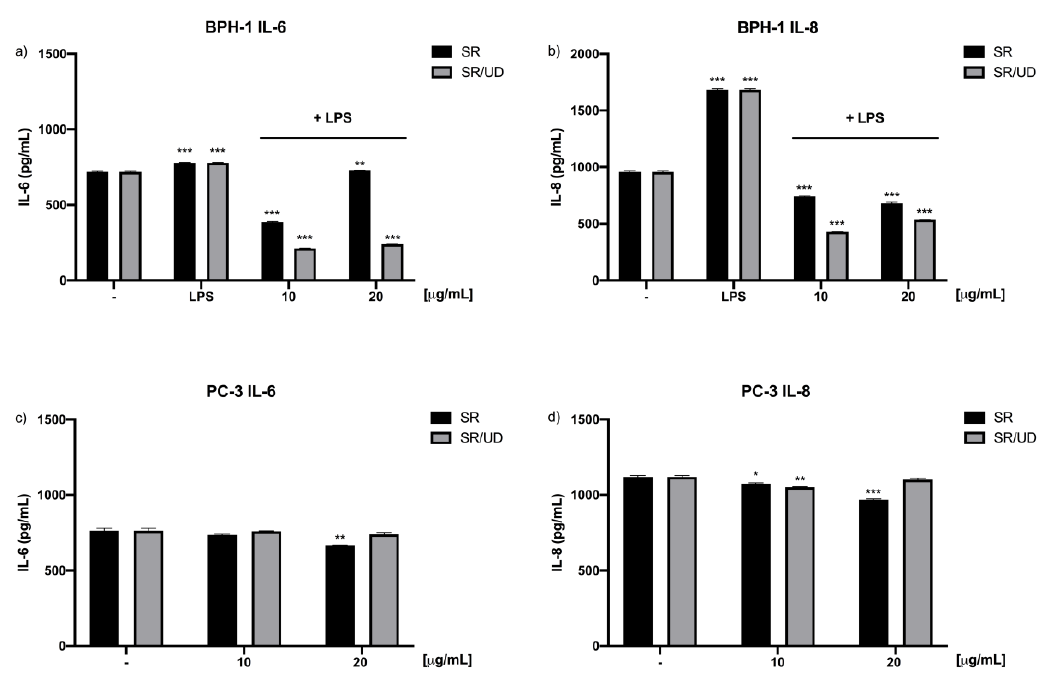
Figure 5. Human IL-6 and IL-8 production (pg / mL) in BPH-1 and PC3 cells. ( a ) IL-6 production by BPH-1 cells pre-treated with SR and SR / UD (10, 20 µ g / mL) for 24 h and stimulated with LPS (10 µ g / mL) for 6 h. ( b ) IL-8 production by BPH-1 cells pre-treated with SR and SR / UD (10, 20 µ g / mL) for 24 h and stimulated with LPS (10 µ g / mL) for 6 h. ( c ) IL-6 expression by PC3 cells treated with SR and SR / UD (10, 20 µ g / mL) for 24 h. ( d ) IL-8 expression by PC3 cells treated with SR and SR / UD (10, 20 µ g / mL) for 24 h. IL-6 and IL-8 are expressed as the ratio between treatments and LPS stimulus. * p < 0.05, ** p < 0.01, *** p < 0.001, LPS stimulus compared to the control or treatment compared to the control. Data represent the mean ± SEM ( n = 3).